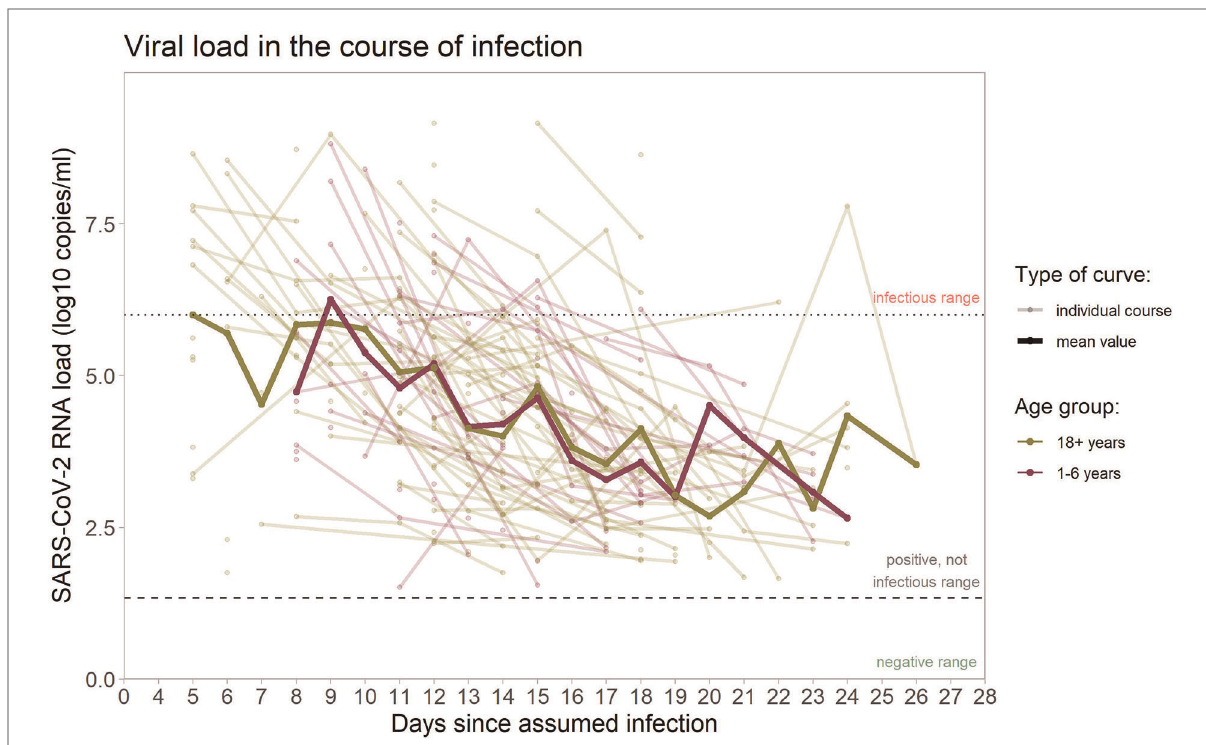
FIGURE 4 SARS-CoV-2 RNA copies/ml in the samples from upper respiratory tract. Viral load courses (individual courses and mean courses of children and adults), shown from the day of assumed infection (day zero) onwards. Dotted line marks 10^6 RNA copies/ml as threshold for infectivity (>=10^6 RNA copies/ml denotes infectious range); dashed line marks threshold for positivity with values >=10^1 RNA copies/ml considered as positive. Analysis restricted to samples considered positive (102 samples in 40 children, 214 samples in 67 adults) with increasingly fewer samples in the progression of the course of